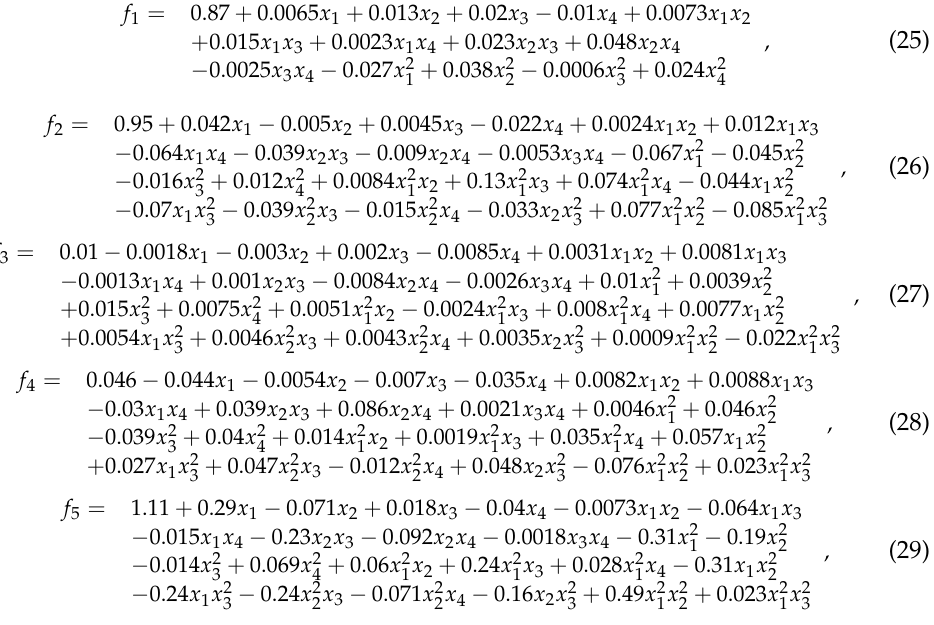
Figure 8. ( a ) Collision efficiency and ( b ) breakage rate coefficient in PBM under the optimal condi- tions. The dynamic evolution of the square-weighted mean chord length of floc obtained by modeling under the optimal conditions can be obtained, as shown in Figure 9.